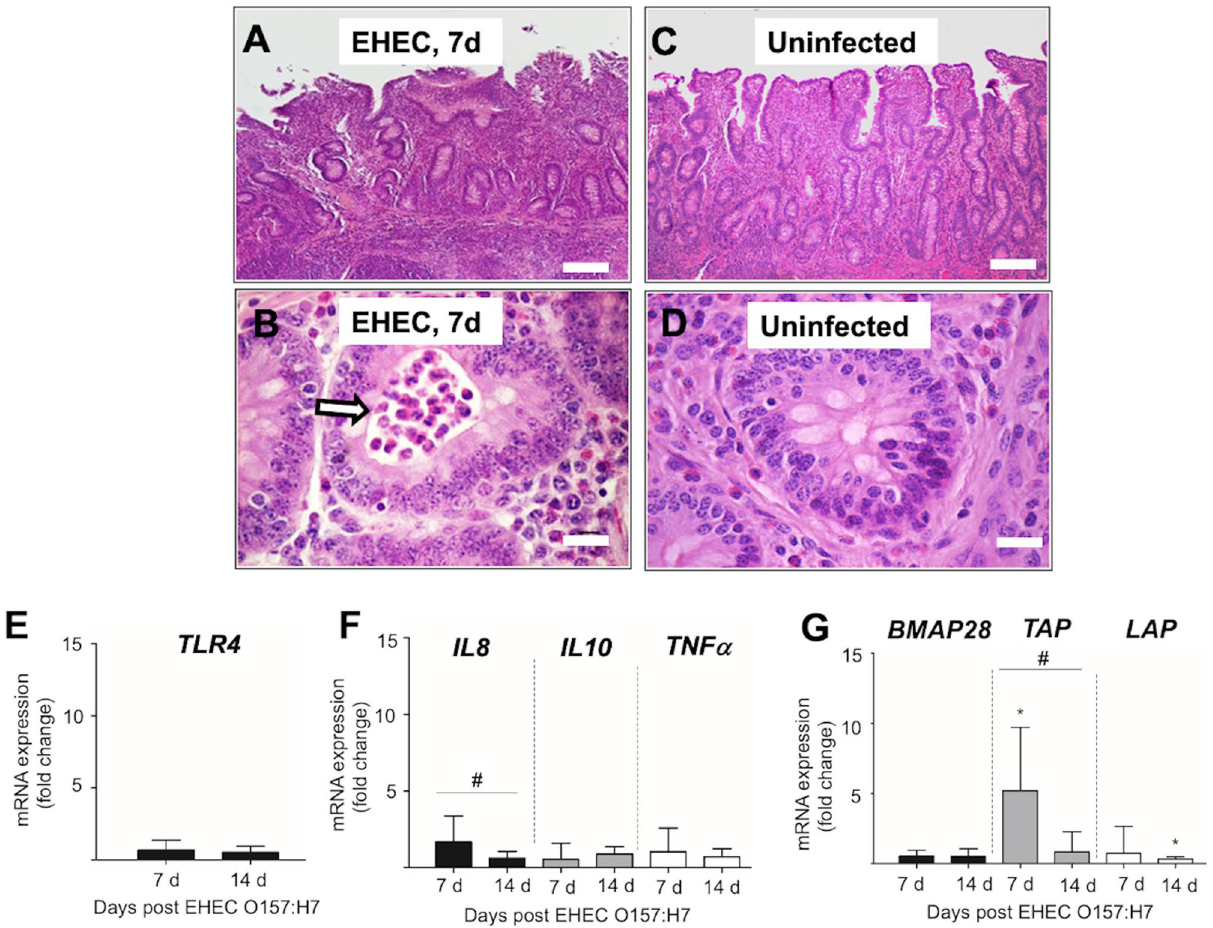
bar = 100 µm) and ( B ) neutrophils accumulated into the lumen of crypts of the ileum (white arrow) (400x, bar = 20 µm). Ileum from an uninfected calf with an intact epithelium ( C ) and crypt without any inflammatory cells ( D ). ( E–G ) Transcriptional gene expression of the TLR4 ( E ), IL8, IL10 and TNF ɑ ( F ), and β-defensins TAP and LAP and cathelicidin BMAP28 ( G ) in the ileum of calves challenged by EHEC O157: H7. RT-qPCR expression of mRNA genes in each sample was conducted in triplicate and the mean + the standard error (SEM) shown. The expression of mRNA is relative to the uninfected controls. Only significant comparisons ( P < 0.05) are noted (one-way ANOVA using Tukey’s post hoc test). A (*) denotes significant differences (p < 0.05) between one infected group and uninfected group and (#) denotes differences (p < 0.05) between infected groups (7 versus 14 d post-challenge). BMAP: bone marrow antimicrobial peptide. TAP : tracheal antimicrobial peptide. LAP : lingual antimicrobial